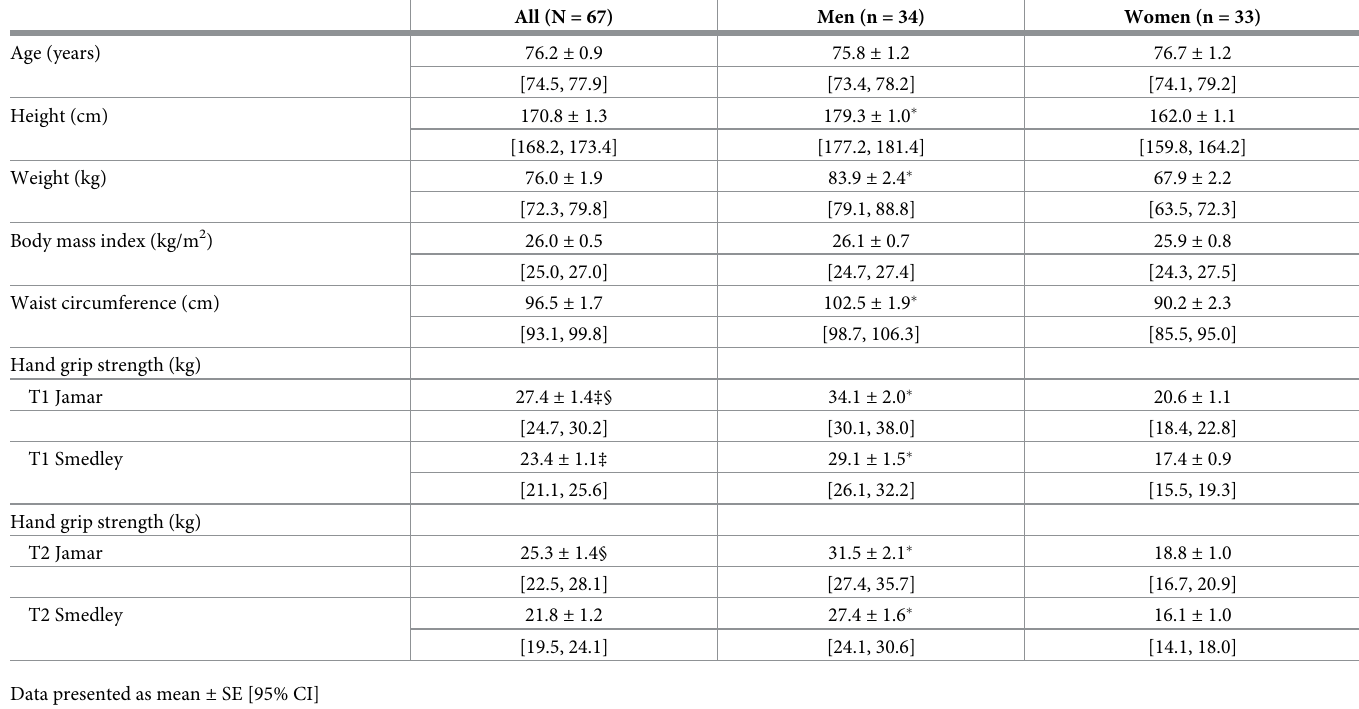
Table 1. Participant